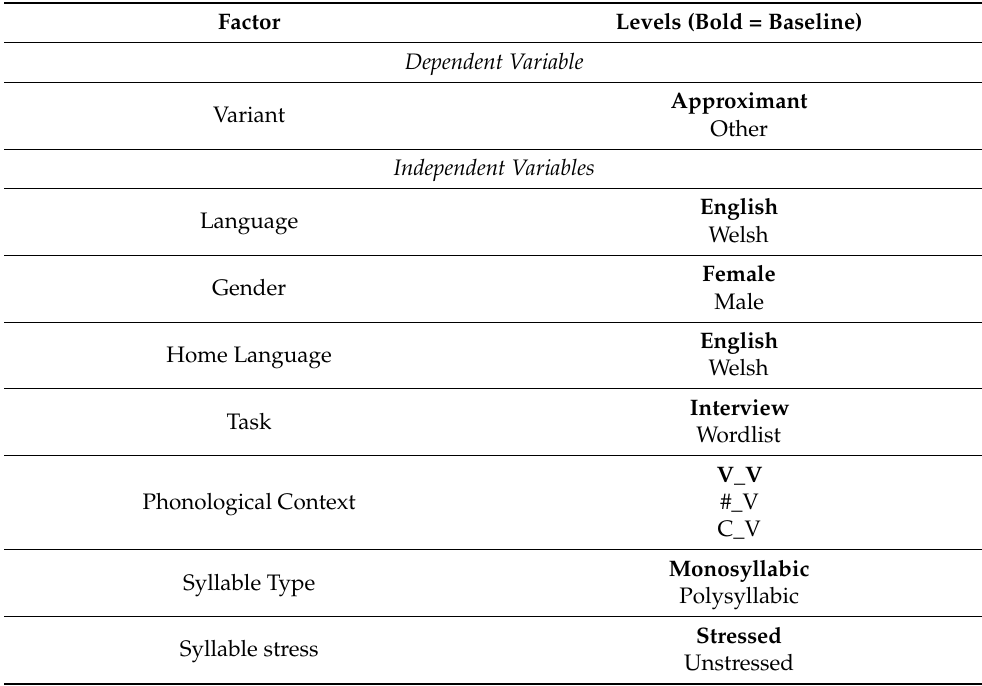
Table 4. Factors included in the statistical analysis of /r/ variation (speaker and word included in all final models as random